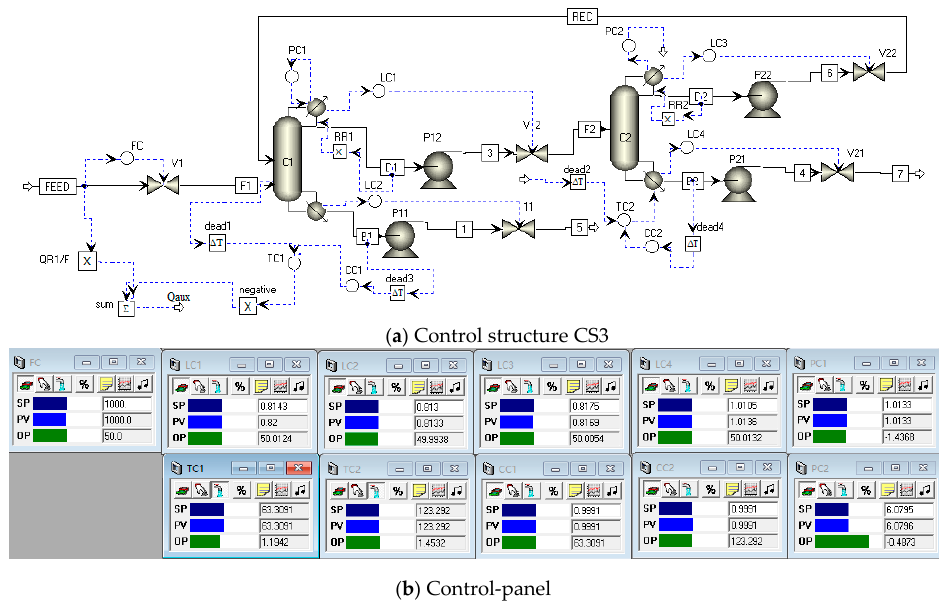
Figure 14. Control structure CS3 and control-panel.